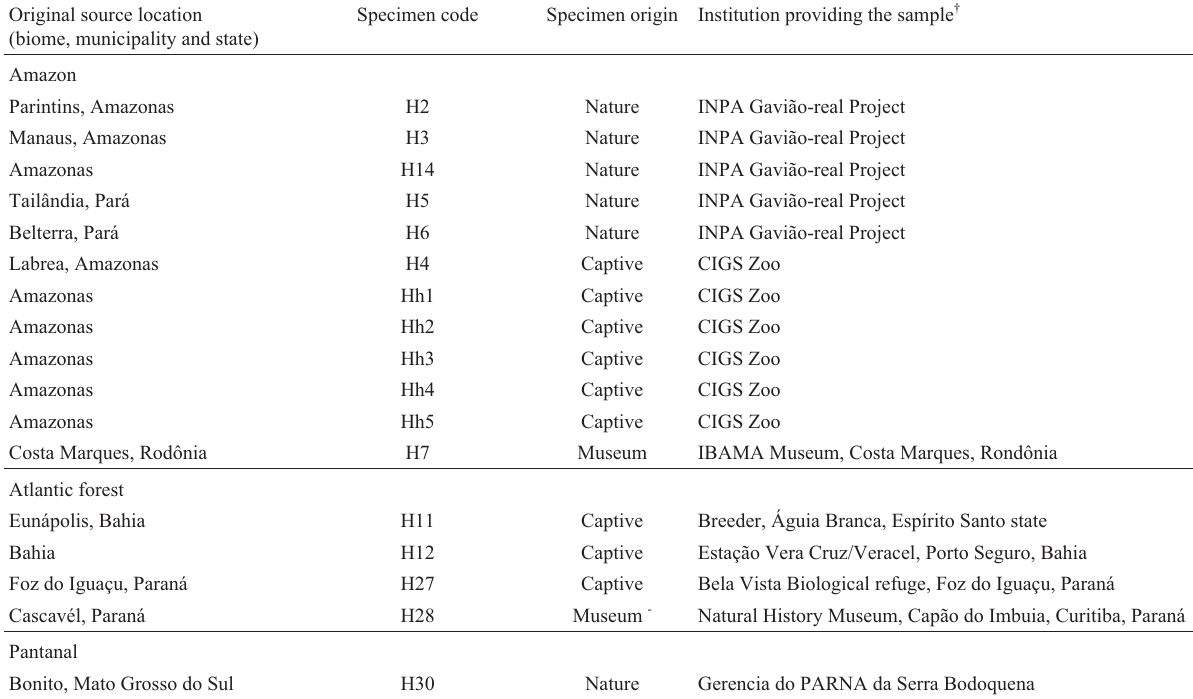
Table 1 - Demographic information for the harpy eagles ( Harpia harpyja ) subjected to microsatellite primer characterization. All birds originated in the wild. Original source location Specimen (biome, municipality and state)